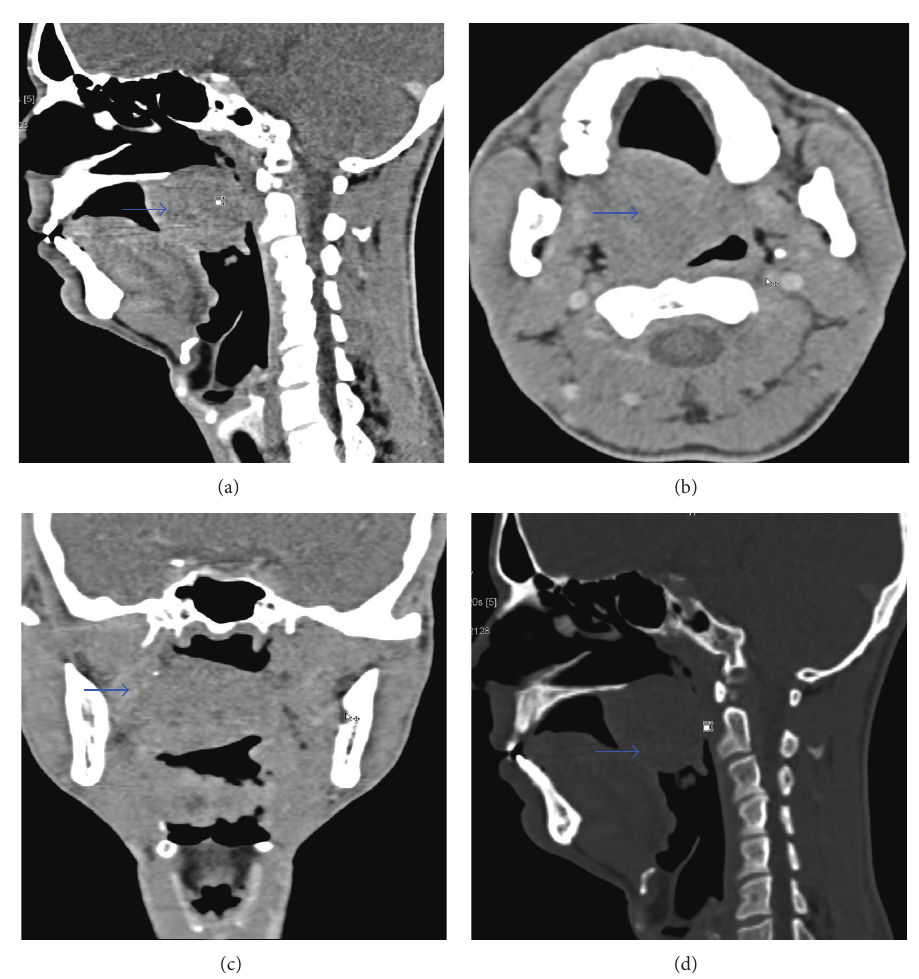
Figure 2: Contrast enhanced CT soft tissue window (a) sagittal section, (b) axial section, (c) coronal section, and (d) bone window showing well defined mildly enhancing heterogeneous soft tissue mass (marked by arrow) arising from soft palate reaching up to the posterior pharyngeal wall causing significant narrowing of nasopharyngeal and oropharyngeal airway. No cystic area or fat or calcification within the mass. The mass is abutting the hard plate with no erosion or